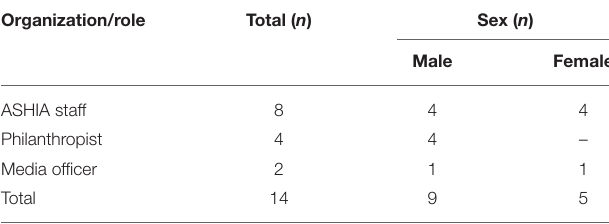
TABLE 1 | The study in-depth interview respondents ( N = 14).